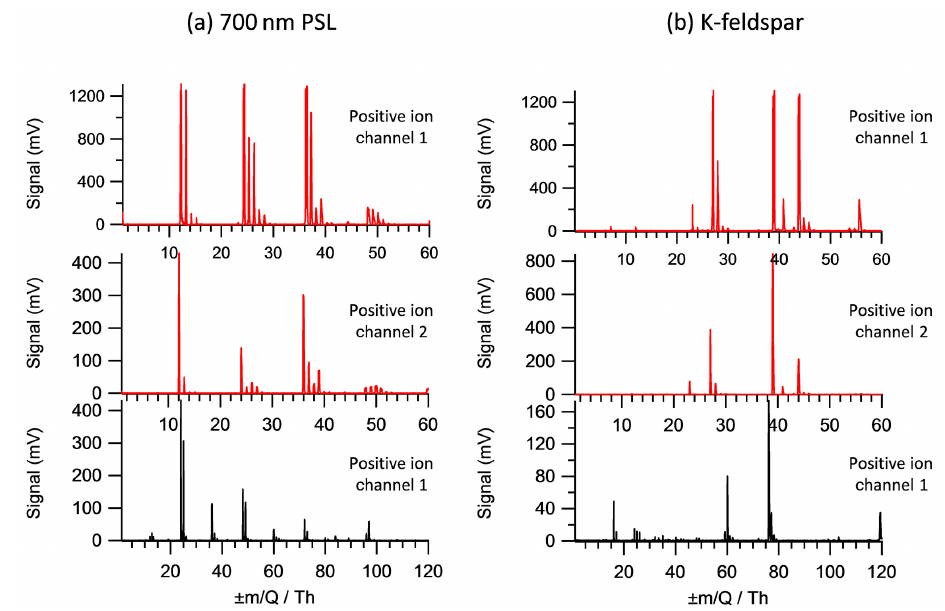
Figure 4. Example spectra of (a) 700nm PSL and (left column) and (b) orthoclase feldspar (right column). The dynamic range of the data is demonstrated by changing the positive ion signal line from Channel 1 (top spectra) to Channel 2 (middle spectra). Negative ion spectra are also shown (bottom spectra).